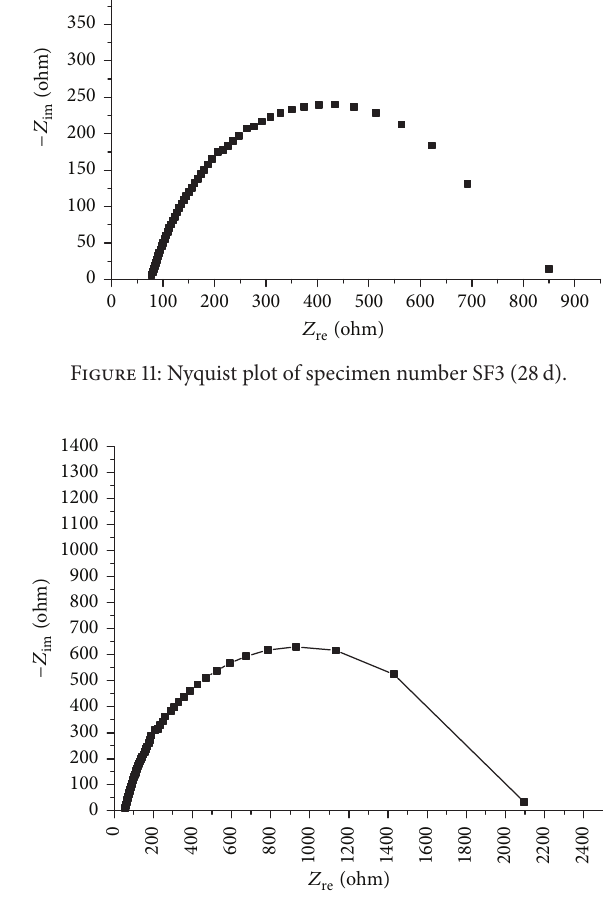
Figure 12: Nyquist plot of specimen number SF3 (90 d).